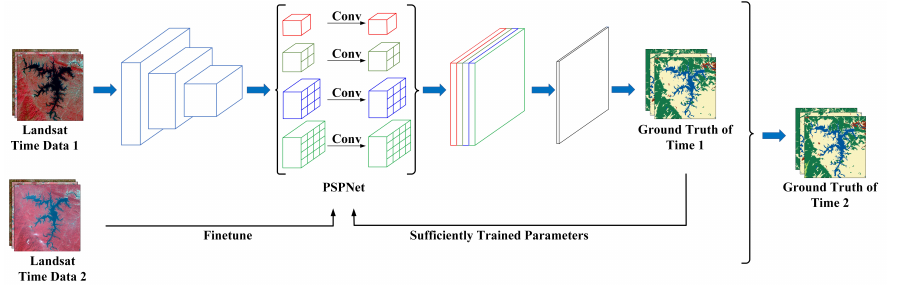
Figure 5. Flowchart of MTNet. Training set of Time 1 was used to train the PSPNet. Then, the trained network was finetuned by the training set of Time 2 to make the network suitable for land cover mapping of images in Time